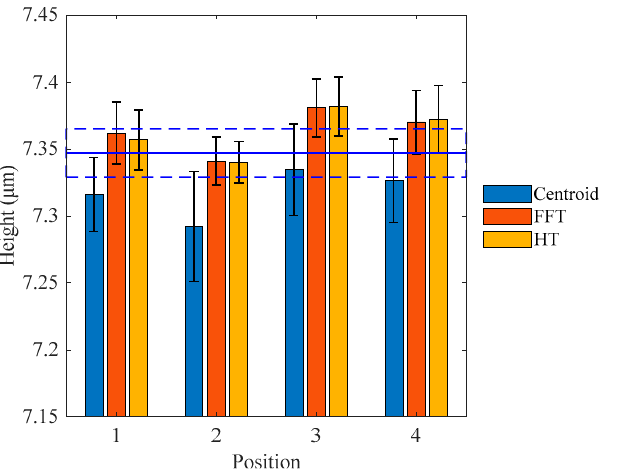
Figure 10. Comparison of mean heights and standard deviations of 7.347 μ m step height at different positions.